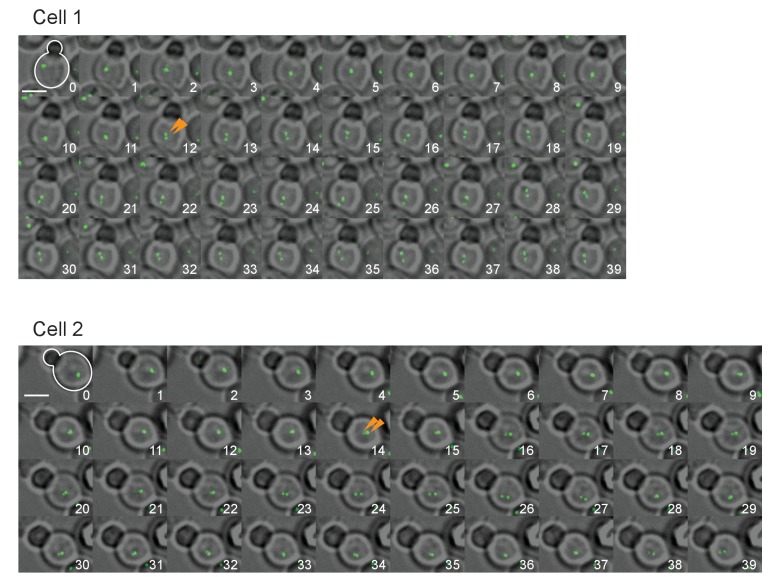
Time lapse microscopy of cells expressing SPB-GFP maker.MPS3-GFP cells (HPH1681) were grown in SD complete medium at 30°C. Consecutive sections were taken every 60 s. Orange arrowhead point separated SPB signals. Shown are deconvolved and projected GFP images merged with bright field image. Scale bar, 2 µm.